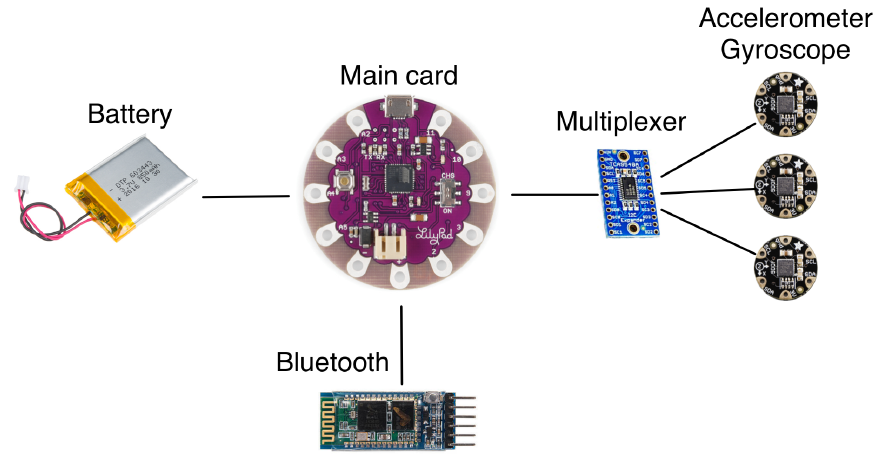
Figure 2. General architecture of the StraightenUp